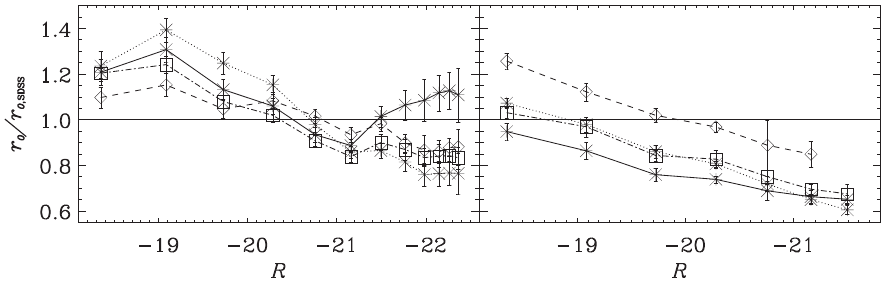
Fig. 4. Ratio of the correlation length of mock and SDSS data as a function of mean R -magnitude. Left panel: m1 to m12 samples for red galaxies. Right panel: m1 to m7 samples for blue galaxies. The different semi-analytic mock samples considered are those of C06 (asterisks and solid line), D07 (asterisks and dotted lines), F08 (open diamonds and dashed line) and G11 (open squares and dot-dashed line). Errors are again 2 standard